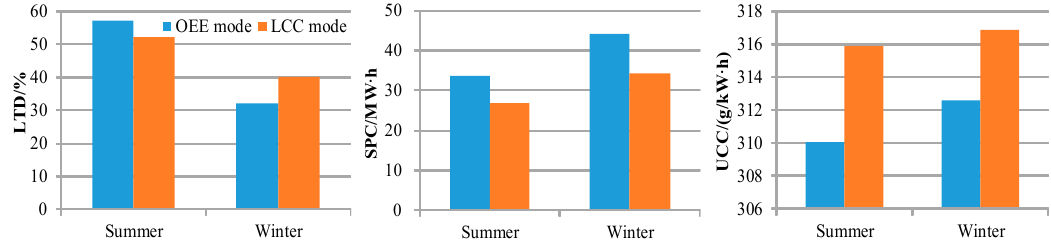
Figure 11. The complementarity indexes of MECS operation under different energy storage devices (ESD) operation modes.